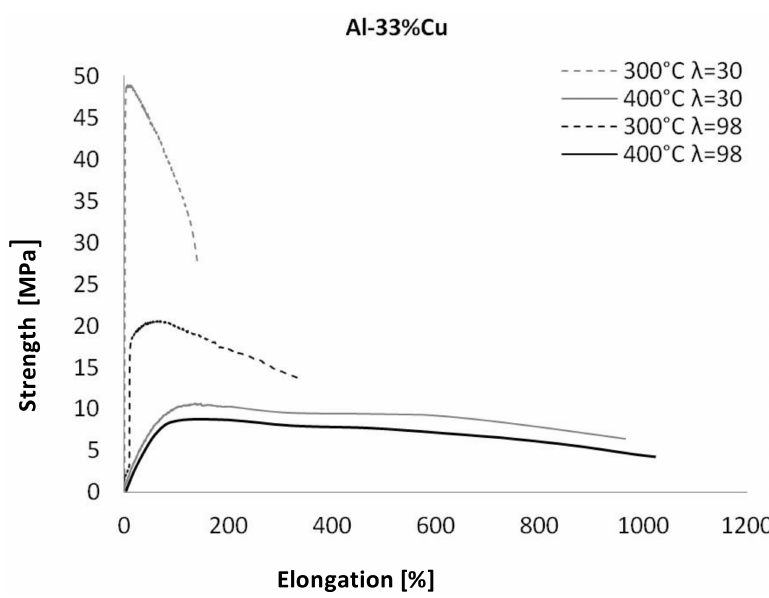
Figure 8. The superplastic tensile stress–strain curves for Al 33 Cu